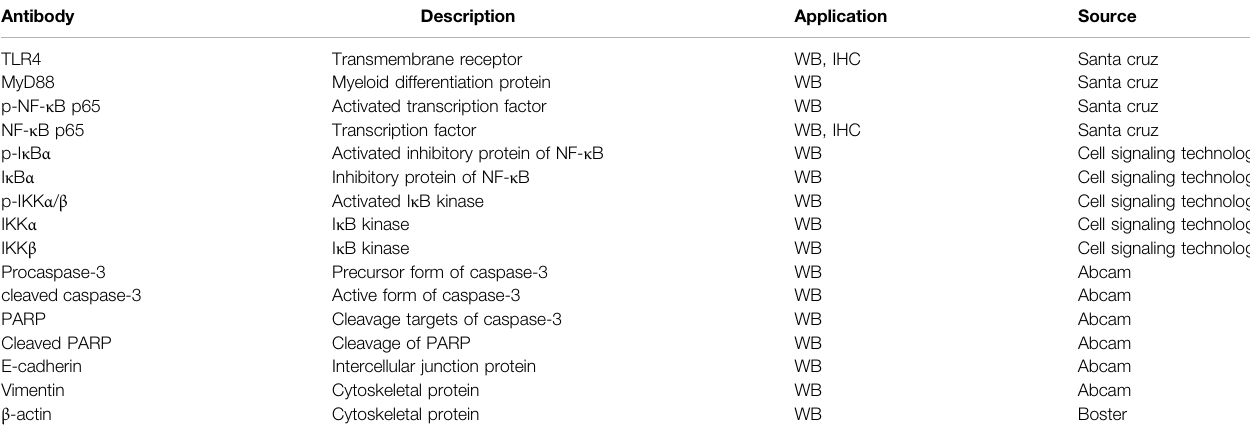
TABLE 1 | Primary antibodies used in this study.